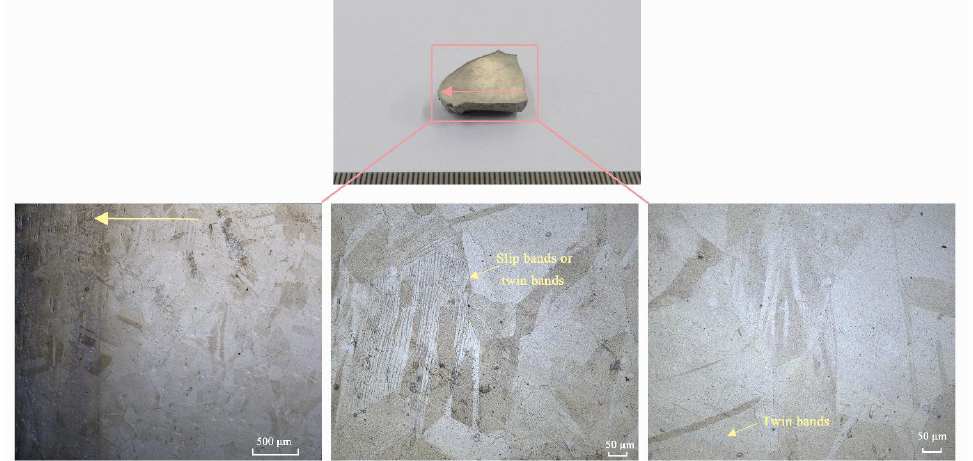
Figure 19. OM images of the initial FeNiCoCr HEA LRP, v = 1429 m/s.